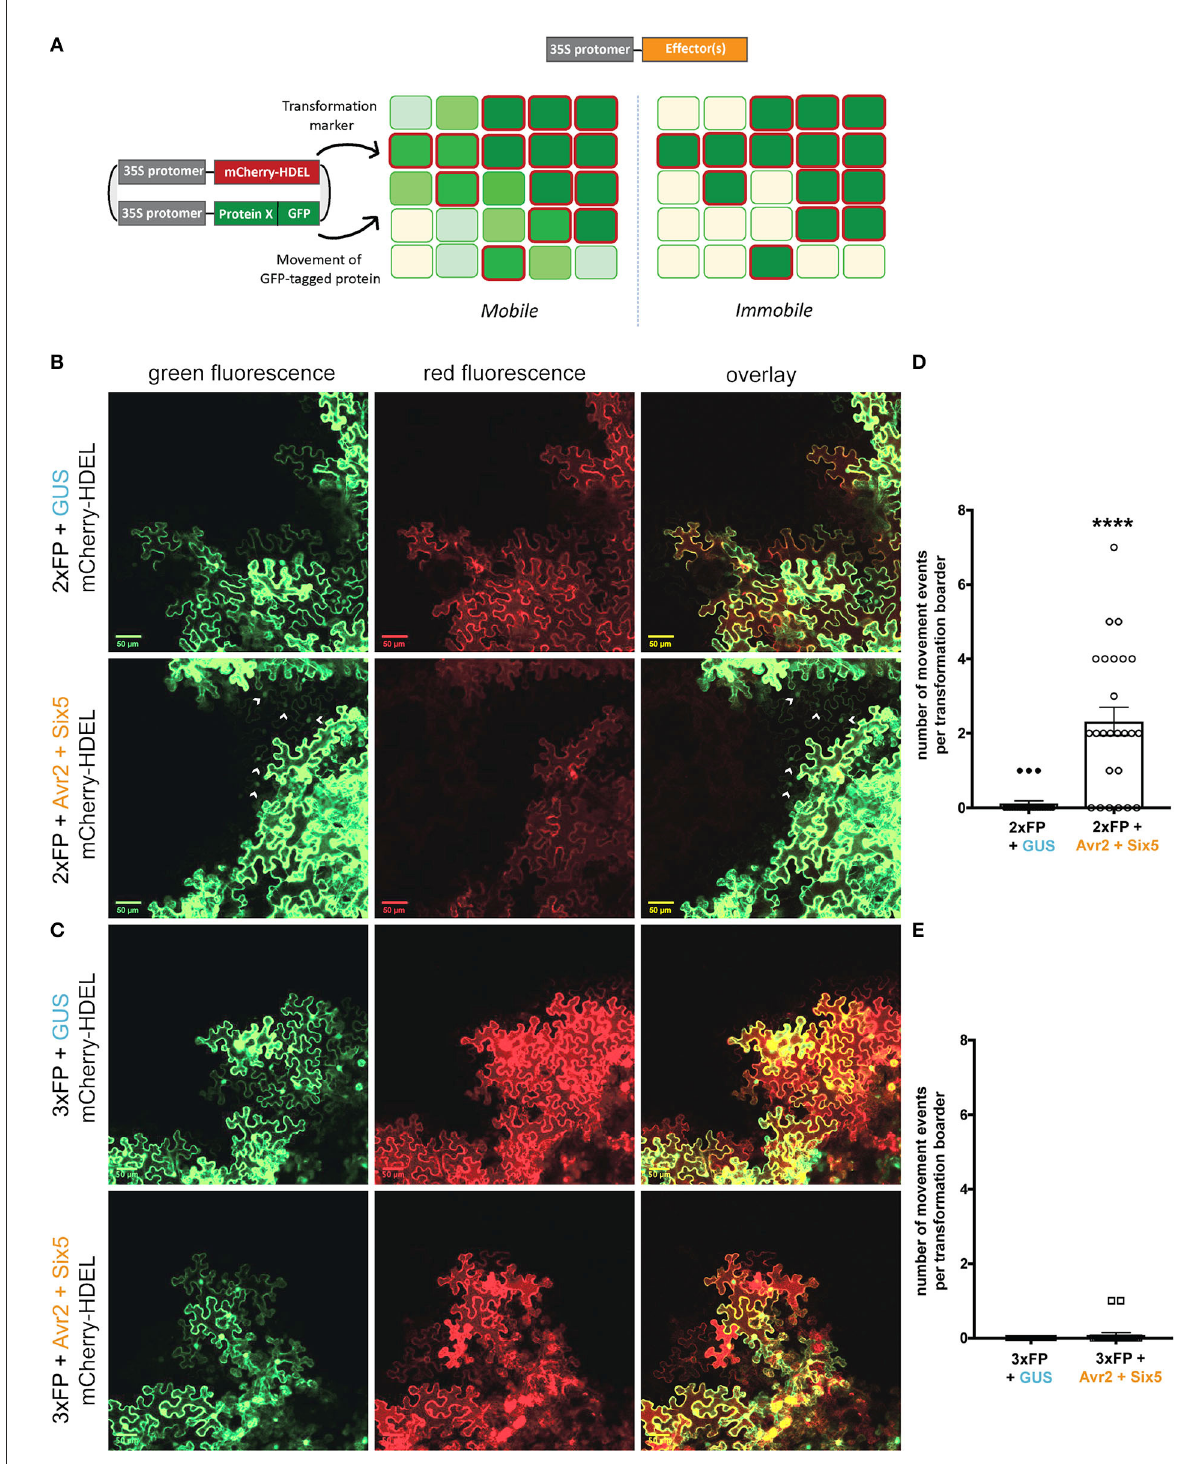
FIGURE3 The Avr2/Six5 effector pair increases the size exclusion limit of plasmodesmata in N . benthamiana. (A) Schematic overview of the setup used to visualize the cell-to-cell movement of green fluorescent proteins (GFP) upon agroinfiltration. The binary vector contains two genes, one encoding a GFP-tagged protein fusion and the other an ER-localized mCherry-HDEL protein that functions as a marker for the transformation of individual cells. Two possible localization patterns are depicted; mobile, where the movement of GFP-tagged proteins is represented as fading shades of green, and immobile, where the GFP signal is retained in the primary transformed cells, outlined in red. (B,C) Co-infiltration of